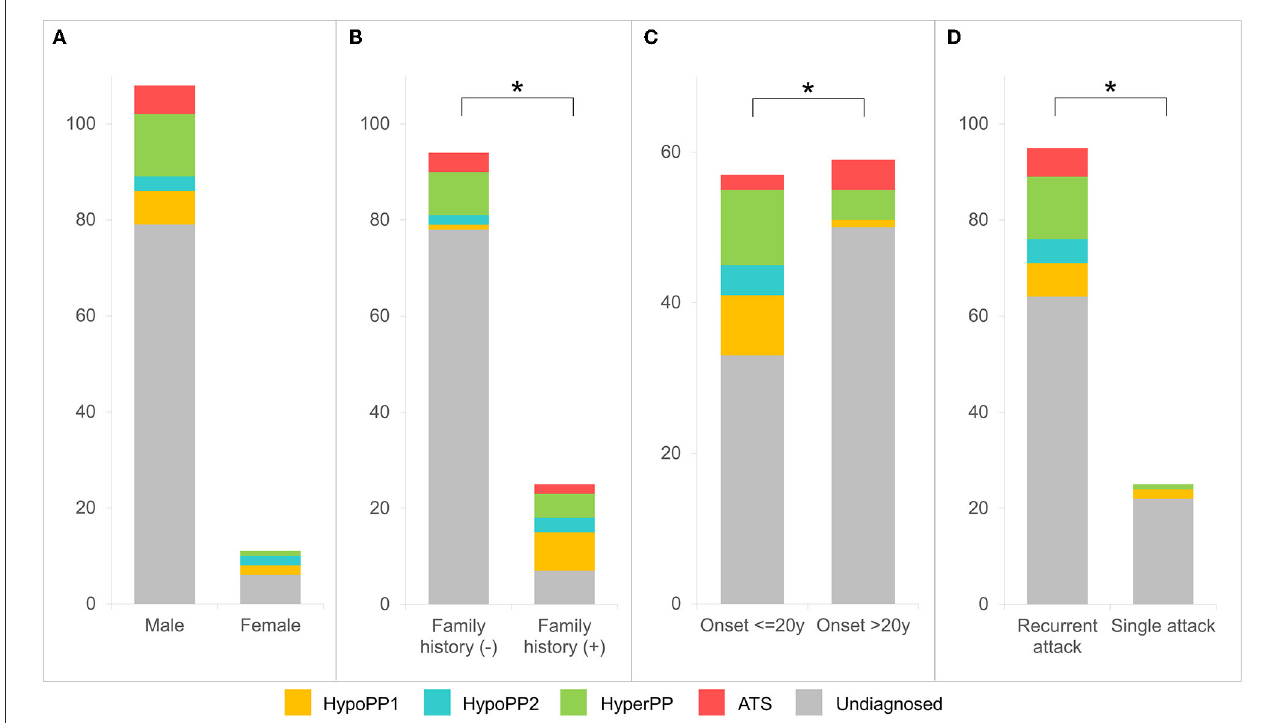
FIGURE2 Clinical and molecular diagnostic rate analyses for patients with PP. Molecular diagnostic rates are observed higher in female patients [ (A) p > 0.05], patients with positive family history [ (B) p < 0.0001], with onset age ≤ 20 years [ (C) p < 0.01], or patients who experienced recurrent paralytic attacks [ (D) p <